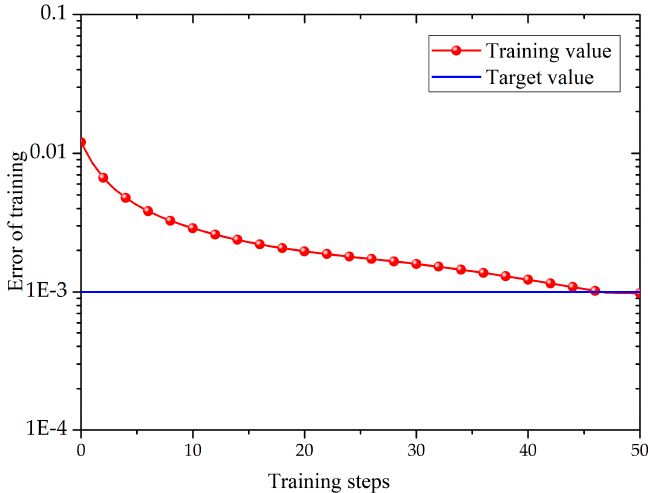
Figure 10. The RS-RBFNN training error curve.